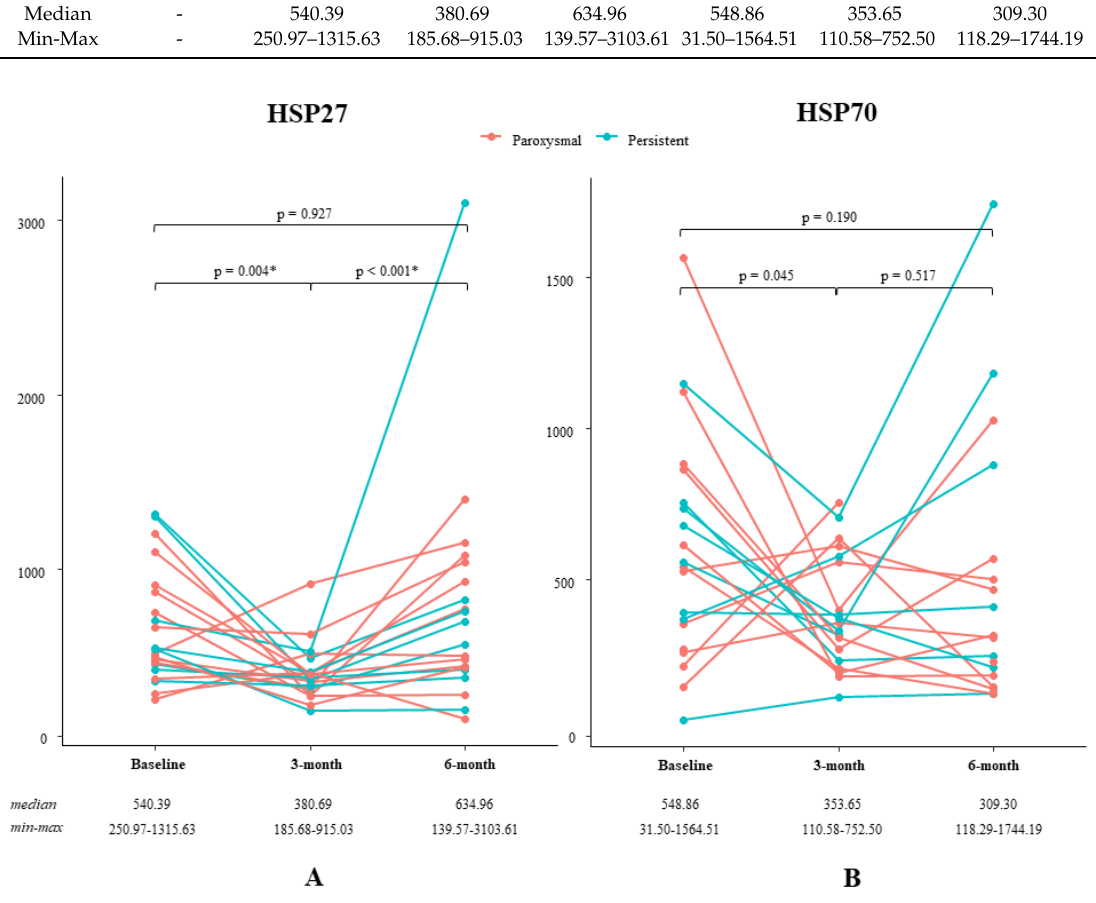
Figure 2. Effect of glutamine on HSP levels. ( A) : Levels of HSP27 per patient during the study period. ( B) : Levels of HSP70 per patient during the study period. Statistical significance is indicated with an asterisk (*, p < 0.0167).